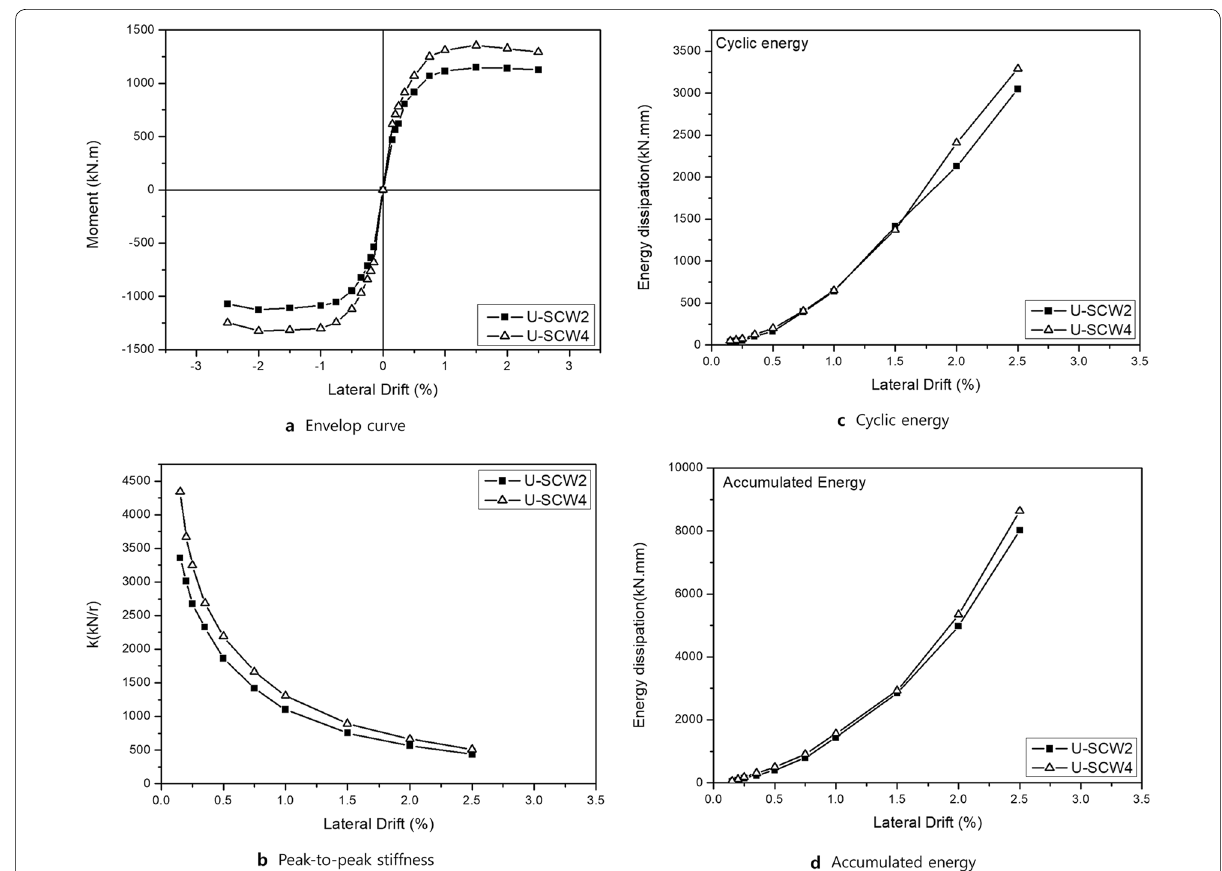
Fig. 16 Comparisons of structural performances for specimens ( P u